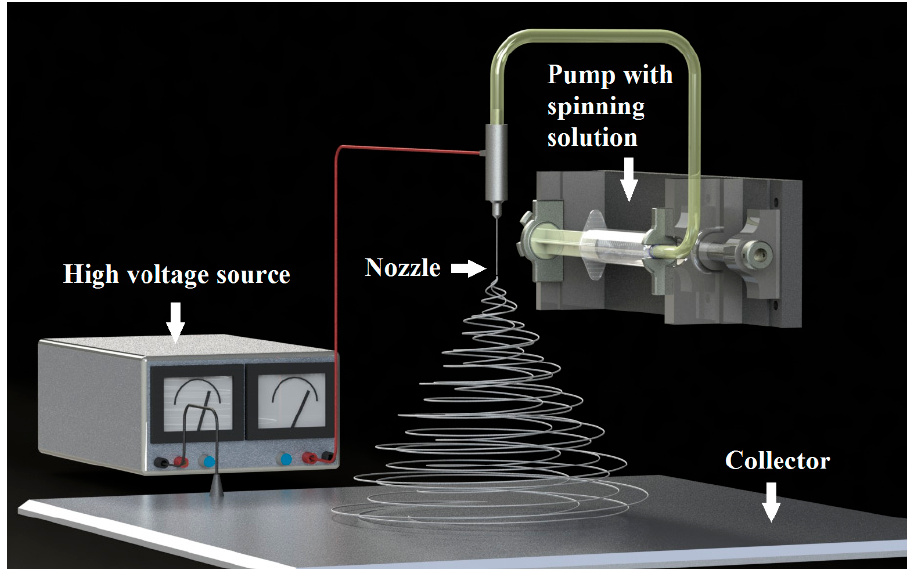
Figure 1. The scheme of the preparation of one-dimensional nanostructures by electrospinning.